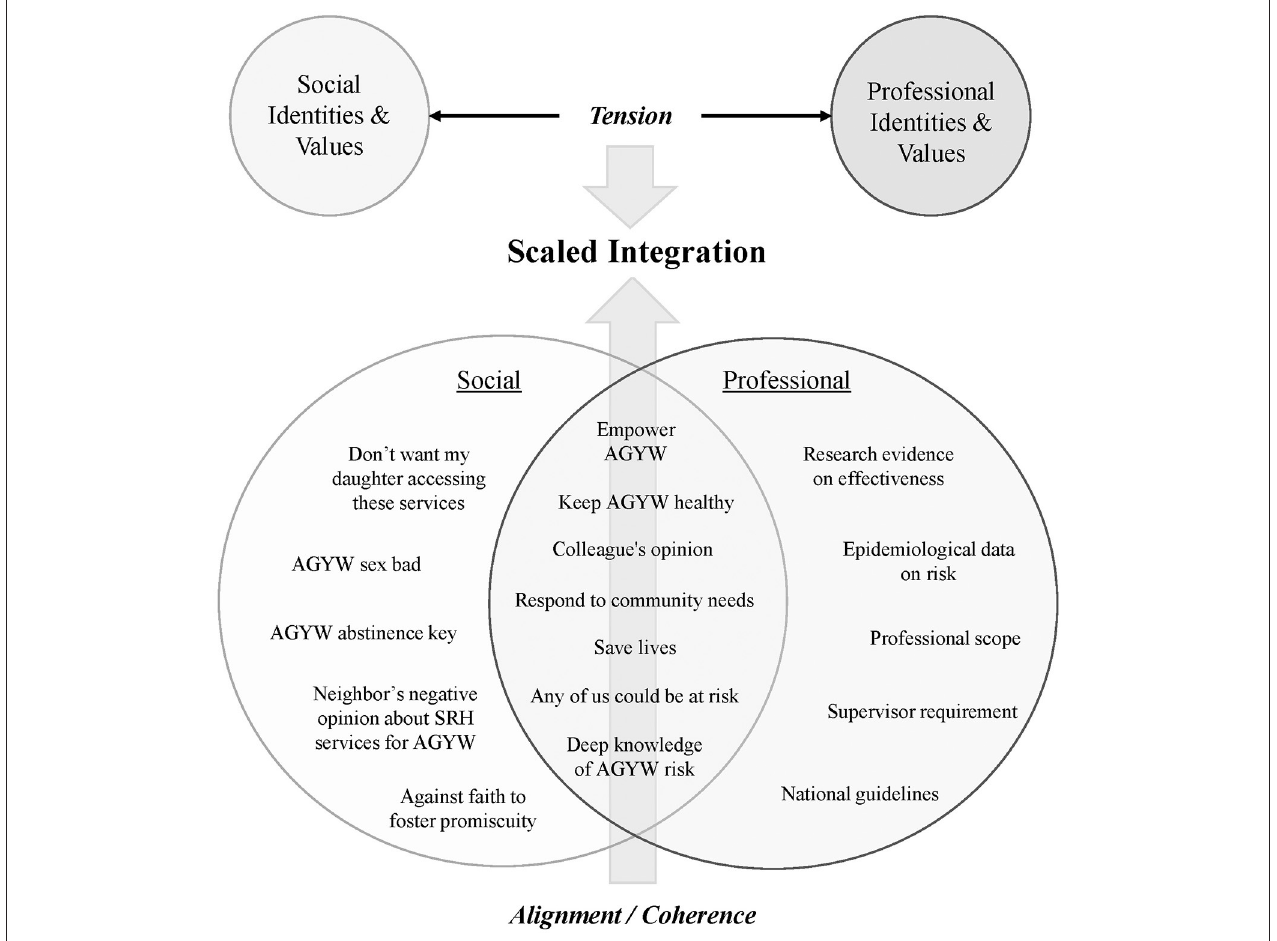
FIGURE 1 | Health care worker